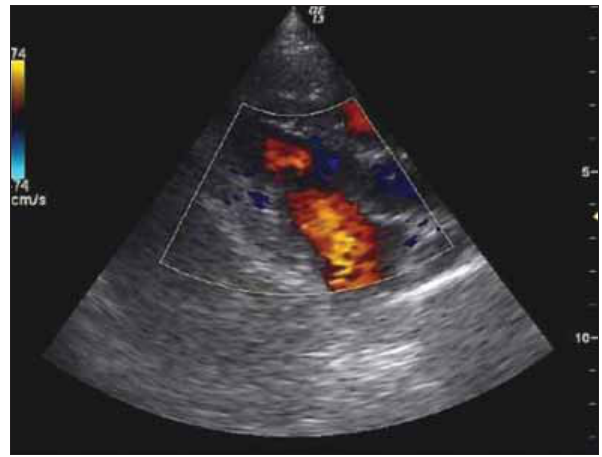
Figure-15: Normal colour doppler with no regurgitation of blood flow.